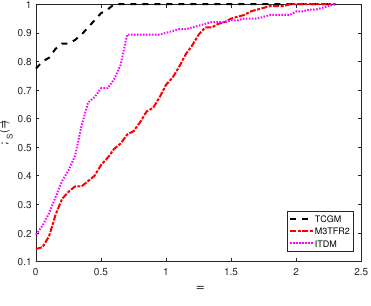
Figure 1. Iterations performance